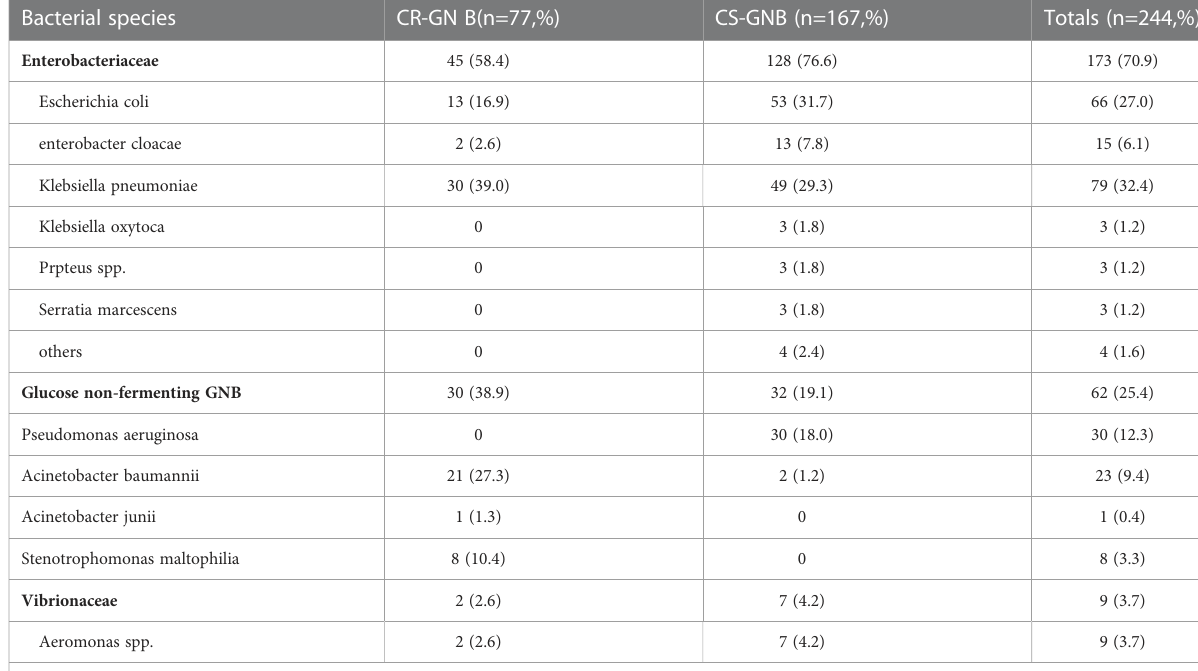
TABLE 1 Distribution of bacterial species and numbers of CR-GNB and CS- GNB. Bacterial species CR-GN B(n=77,%) CS-GNB (n=167,%) Totals